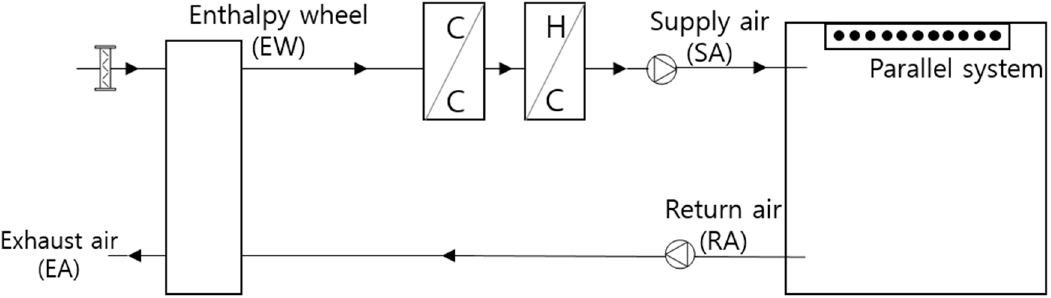
Figure 3. Schematic diagram of DOAS with parallel system. DOAS with Parallel System Operation